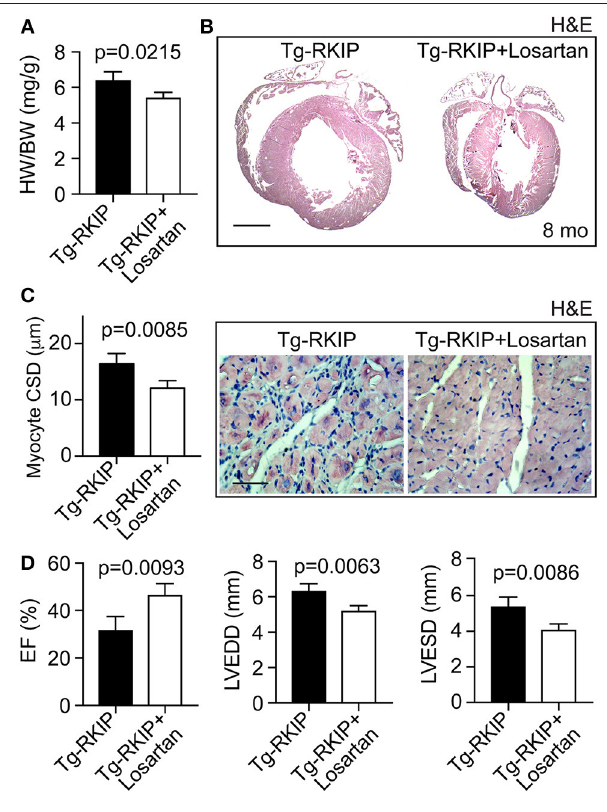
FIGURE 12 | Inhibition of the AT1 receptor retards RKIP-induced symptoms of heart failure. (A–C) Treatment for 3 months with the AT1 antagonist, losartan, retards the development of RKIP-induced cardiac hypertrophy in 8-month-old Tg-RKIP mice with FVB background as evidenced by a decreased heart-to-body weight ratio (A) , histological analysis ( B ; bar: 2mm), and cardiomyocyte cross-sectional diameter ( C ; bar 20 µ m). Data represent mean ± s.d.; n = 4 (A,C) . Sections were stained with hematoxylin-eosin (H&E) and are representative of four mice/group (B,C) . (D) Left ventricular ejection fraction (left), left ventricular end-diastolic diameter (middle), and left ventricular end-systolic diameter (right) of Tg-RKIP mice without and with losartan treatment were determined by echocardiography ( ± s.d.; n =